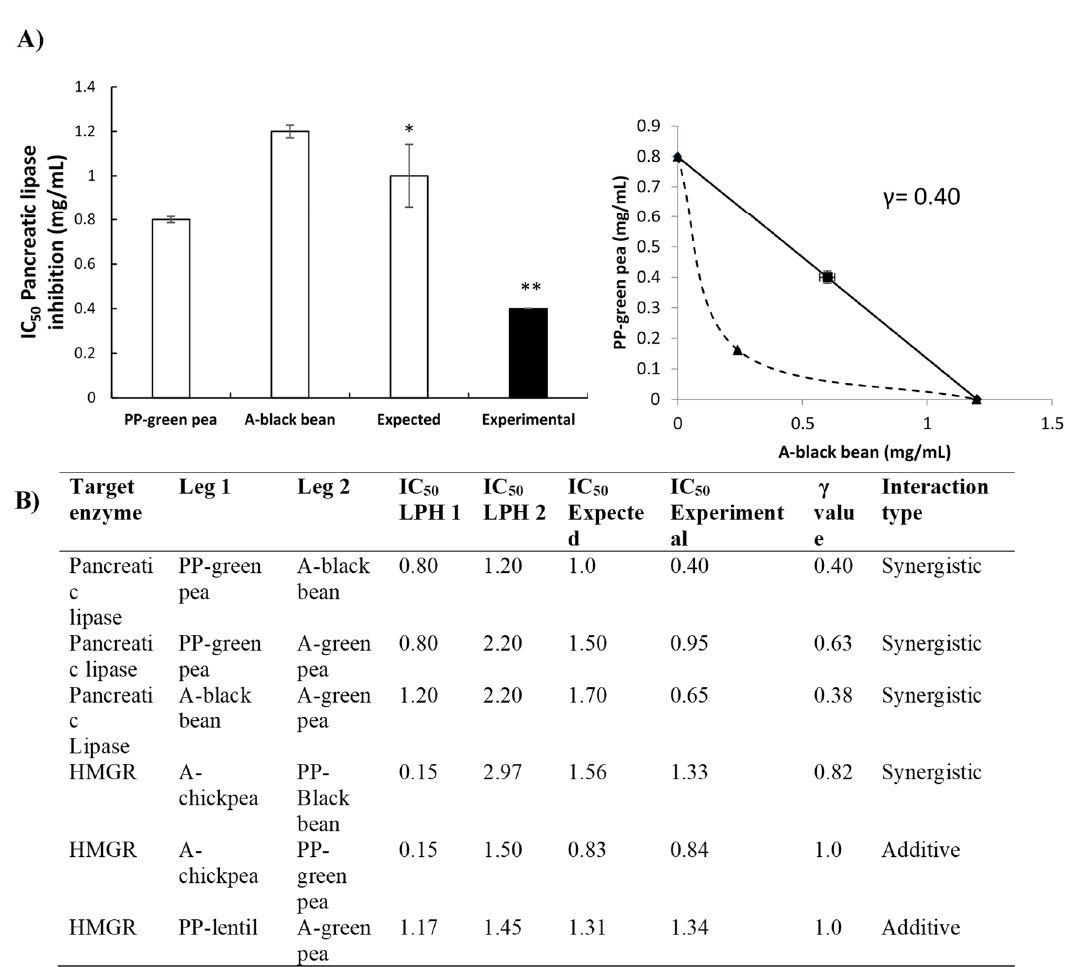
Figure 5. ( A ) Synergistic interaction of PP–green pea and A–black bean hydrolysates to block pancreatic lipase (IC 50 mg/mL). Bar plots represent the mean ± standard deviation of at least two independent experiments, with only the expected and combined values compared statistically. Different number of stars means significant difference ( p < 0.05). The lower the values, the more potency. Results represent the mean ± SD of at least two independent experiments. ( B ) Interactions between legume hydrolysate combinations to block pancreatic lipase and 3-hydroxy-3-methylglutaryl coenzyme A reductase HMGR. Results are expressed in IC 50 mg/mL; γ value < 1 synergism, γ value = 1 additive effect, γ value > 1 antagonism.